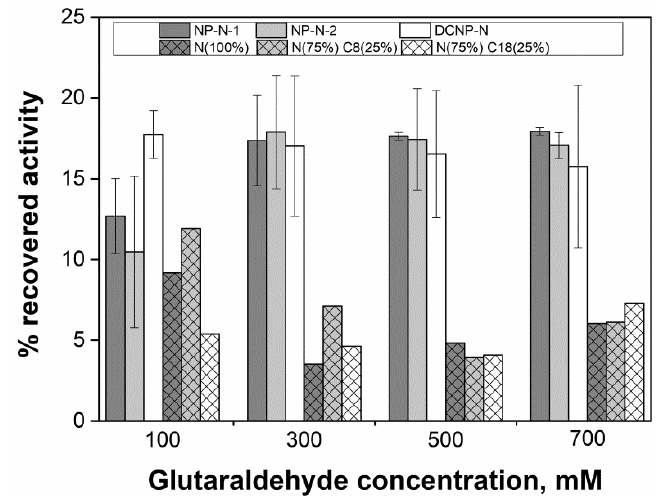
Figure 6. Effect of different commercial aminated magnetic nanoparticles (NP-N-1, NP-N-2, N(100%), N(75%)-C8(25%), N(75%)-C18(25%)) on the recovered activity of CLEAs of amyloglucosidase (AMG 300L). Synthesis conditions: enzyme/magnetic nanoparticle mass ratio of 1:1, ethanol/enzyme solution